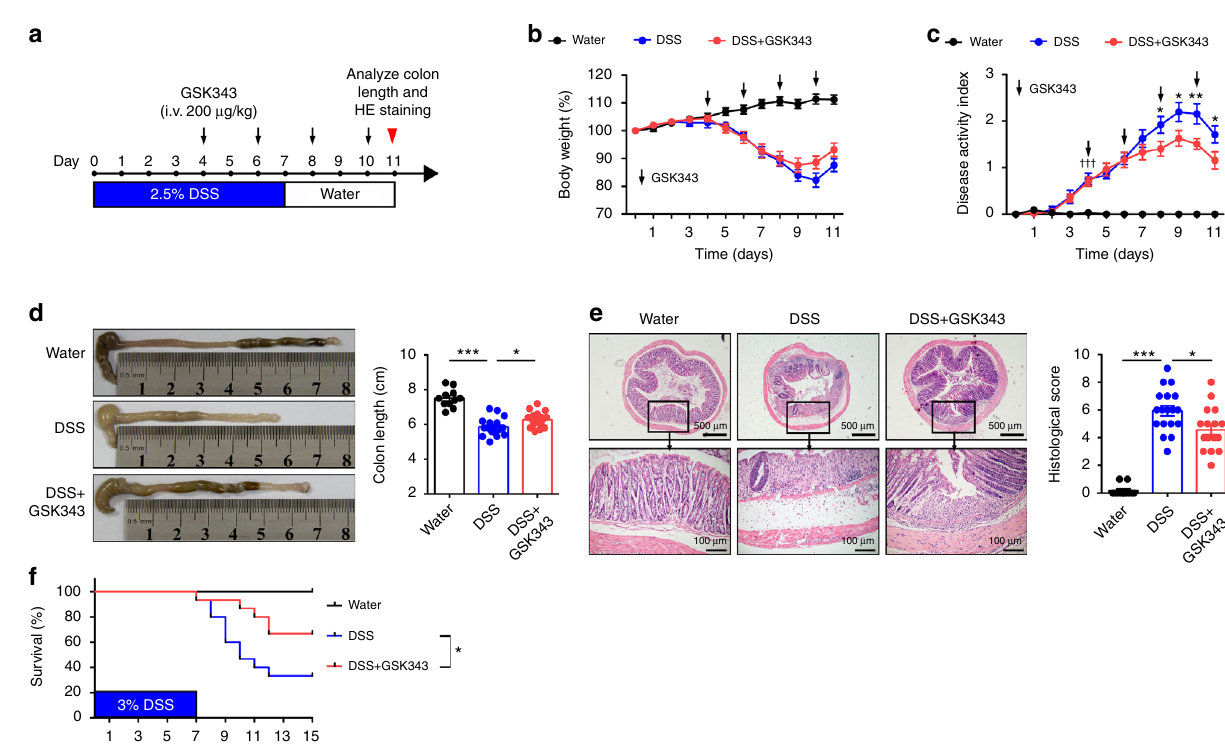
Fig. 2 Therapeutic inhibition of EZH2 activity alleviates DSS colitis. a The experimental design of the therapeutic treatment with GSK343 on DSS-induced acute colitis in C57BL/6 mice. b , c Body weight ( b ) and disease activity index ( c ) ( n = 11, Water; n = 18 for both DSS and DSS + GSK343) of mice that received regular drinking water alone (Water group, black dotted line) or 2.5% DSS (DSS group, blue dotted line), or 2.5% DSS combined with GSK343 injection (DSS + GSK343 group, red dotted line). For statistical comparisons, dagger indicates DSS vs. Water and asterisk indicates DSS vs. DSS + GSK343. d , e Colon length ( d ), representative H&E image of distal colon sections and corresponding histological scores ( e ) at day 11 after DSS exposure ( n = 11, Water; n = 18 for both DSS and DSS + GSK343). f Survival curves of the indicated mice ( n = 15 per group). Data are representative of three independent experiments. * P < 0.05 by log-rank test. b – e Data are representative of three independent experiments. The statistical signi fi cance of differences was determined by two-way analysis of variance with Bonferroni post-test ( b , c ), and one-way analysis of variance followed by Bonferroni